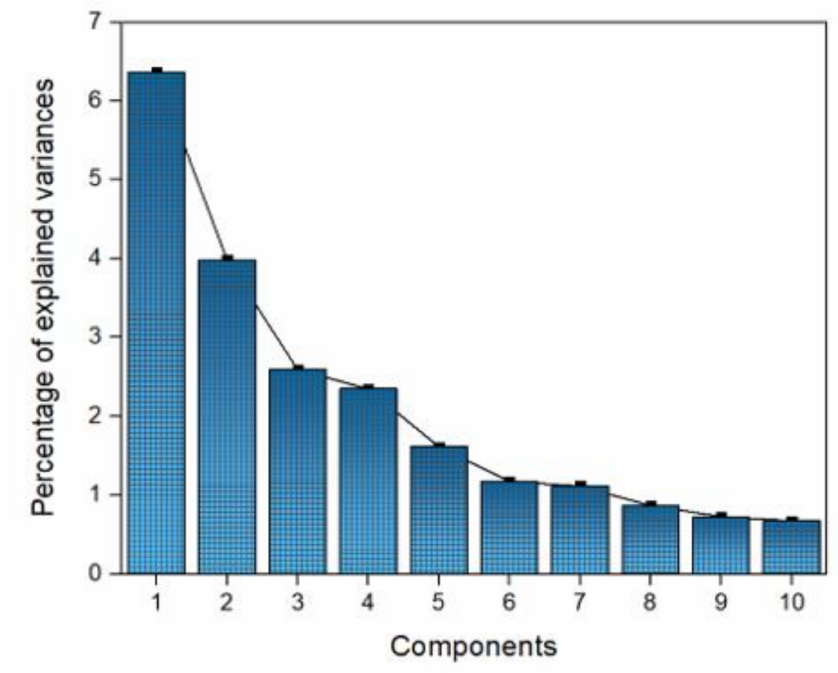
Figure 7. Percentages of the explained variances for each